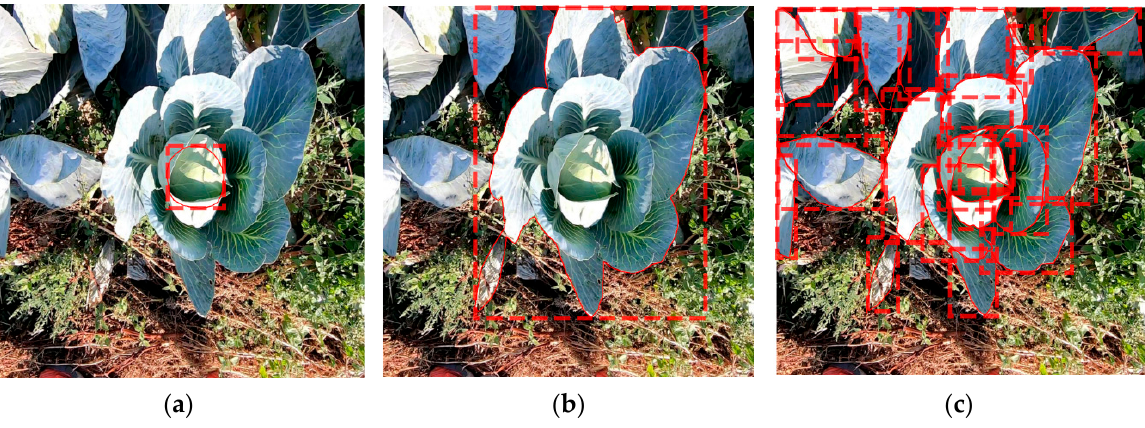
Figure 5. Ground truth instance segmentation masks of the cabbage head ( a ), the whole cabbage plant ( b ) and all cabbage leaves ( c ) at BBCH stage 48.